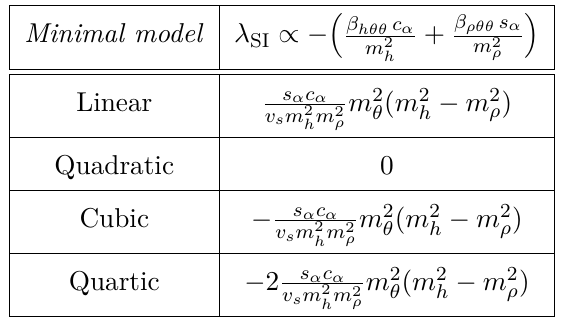
Table 1. Effective DM-nucleon coupling that enters in the DD cross section in terms of the physical parameters v, v and s s , m h , m θ , m ρ α